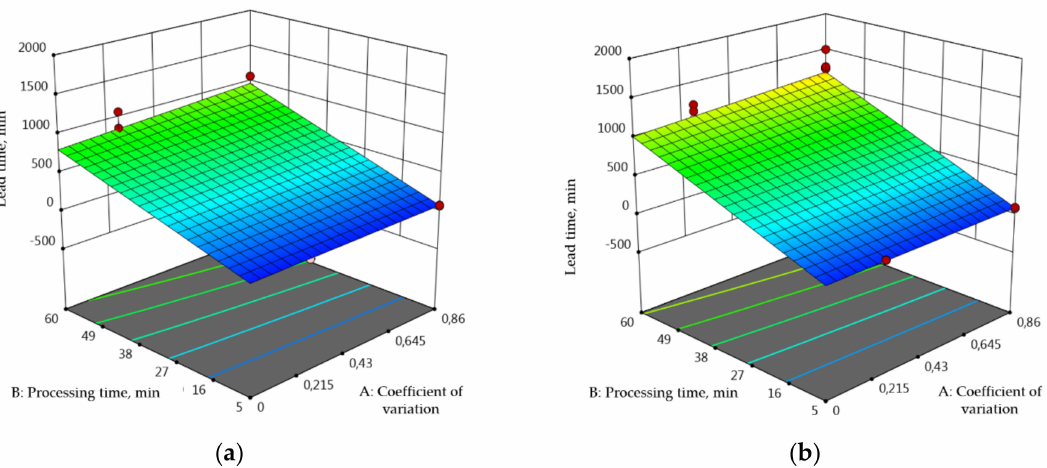
Figure 7. Response surface 3D plots: ( a ) Effects of coefficient of variation and operation time on lead time for the process with bottleneck and two cards in each operation; ( b ) Effects of coefficient of variation and operation time on lead time for the process with bottleneck and three cards in each